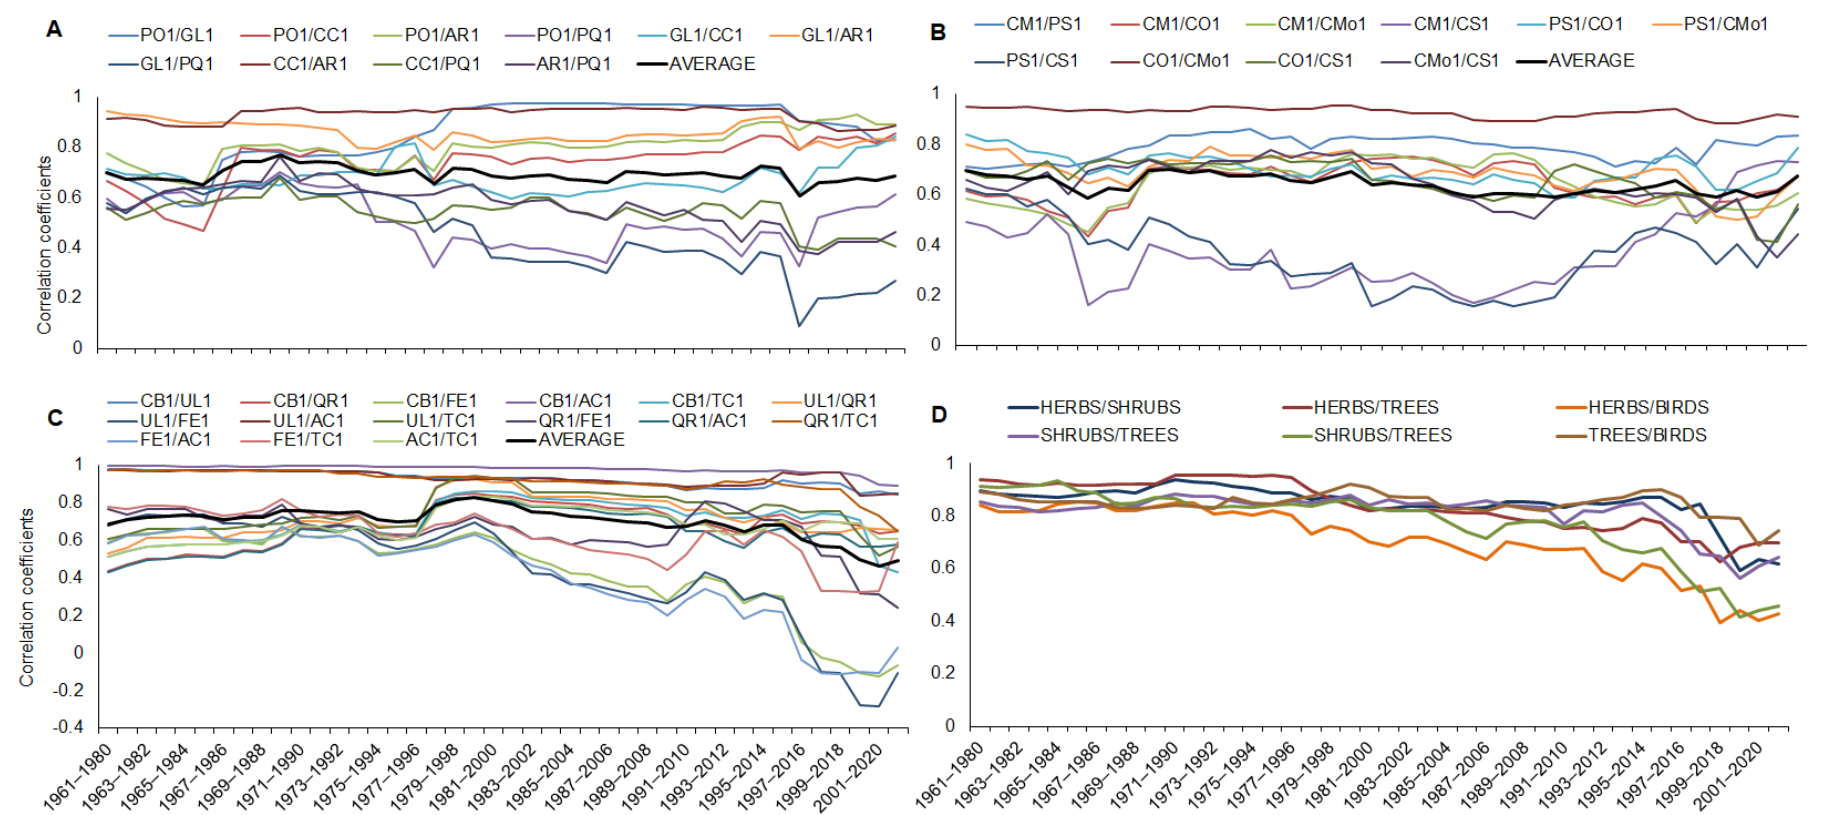
Figure 5. Running correlations for terms of phenological phases among all herbs ( A ), shrubs ( B ), and trees ( C ) and averaged terms of phenophases for herbs, shrubs, trees, and bird species ( D ). Abbreviations for each species: PO1— Pulmonaria officinalis ; GL1— Gagea lutea ; CC1— Corydalis cava ; AR1— Anemone ranunculoides ; PQ1— Paris quadrifolia ; CM1— Cornus mas ; PS1— Prunus spinosa ; CO1— Crataegus oxyacantha ; CMo1— Crataegus monogyna ; CS1— Cornus sanguinea ; CB1— Carpinus betulus ; UL1— Ulmus laevis ; QR1— Quercus robur ; FE1— Fraxinus excelsior ; AC1— Acer campestre ; TC1— Tilia cordata ; and PM1— Parus major .